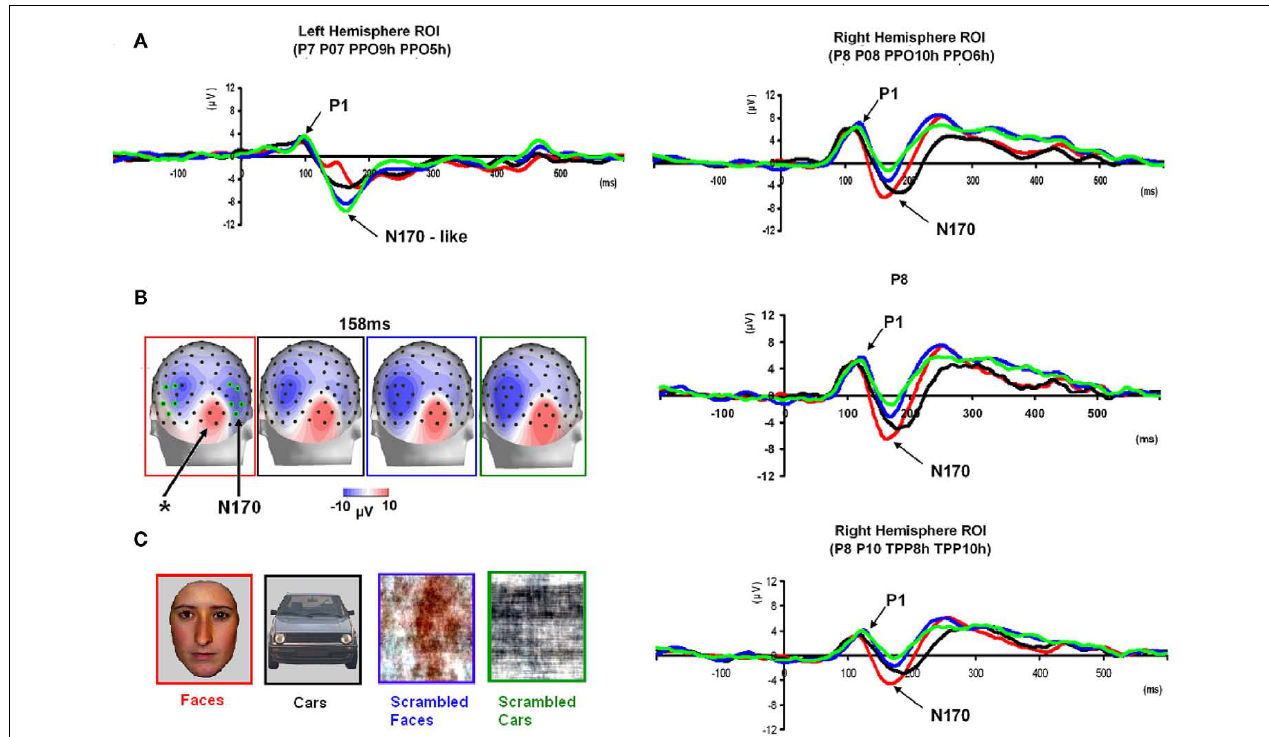
in normal controls due to the presence of a large unusual visual component recorded on the right posterior medial channels, over the main right hemisphere lesion (indicated in the figure with an asterisk).The “N170-like” component, recorded on electrode sites over the left lateral occipital channels, did not show any of the characteristics associated with an N170, presenting the largest response to phase-scrambled stimuli and the lowest and most delayed response to faces. Different ROIs are presented because the larger response to faces than the other conditions was most pronounced on more anterior lateral channels (B,C) than on channels where all conditions elicited the largest N170 (A) .